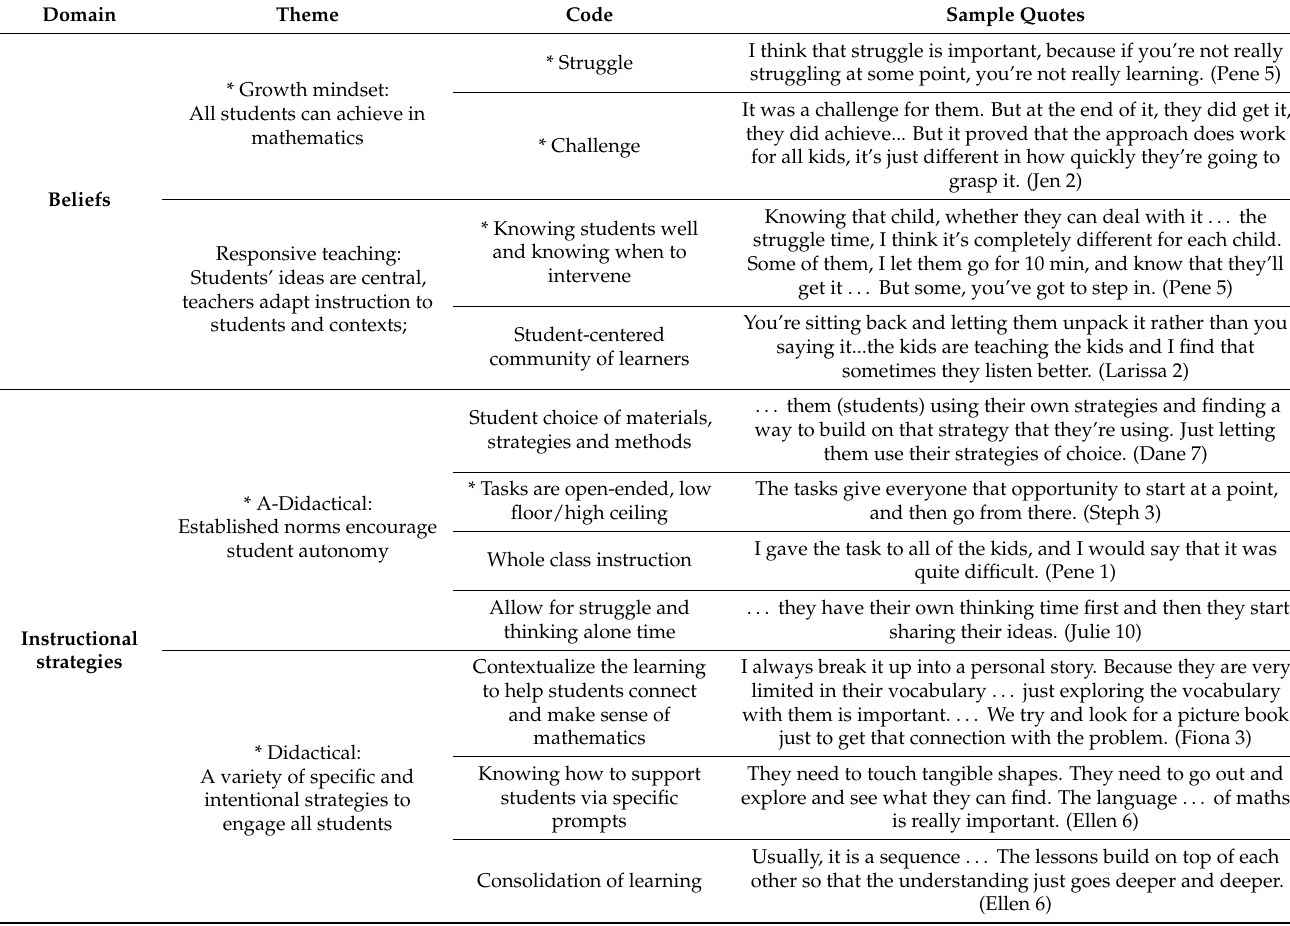
Table 2. Major themes, codes. and sample